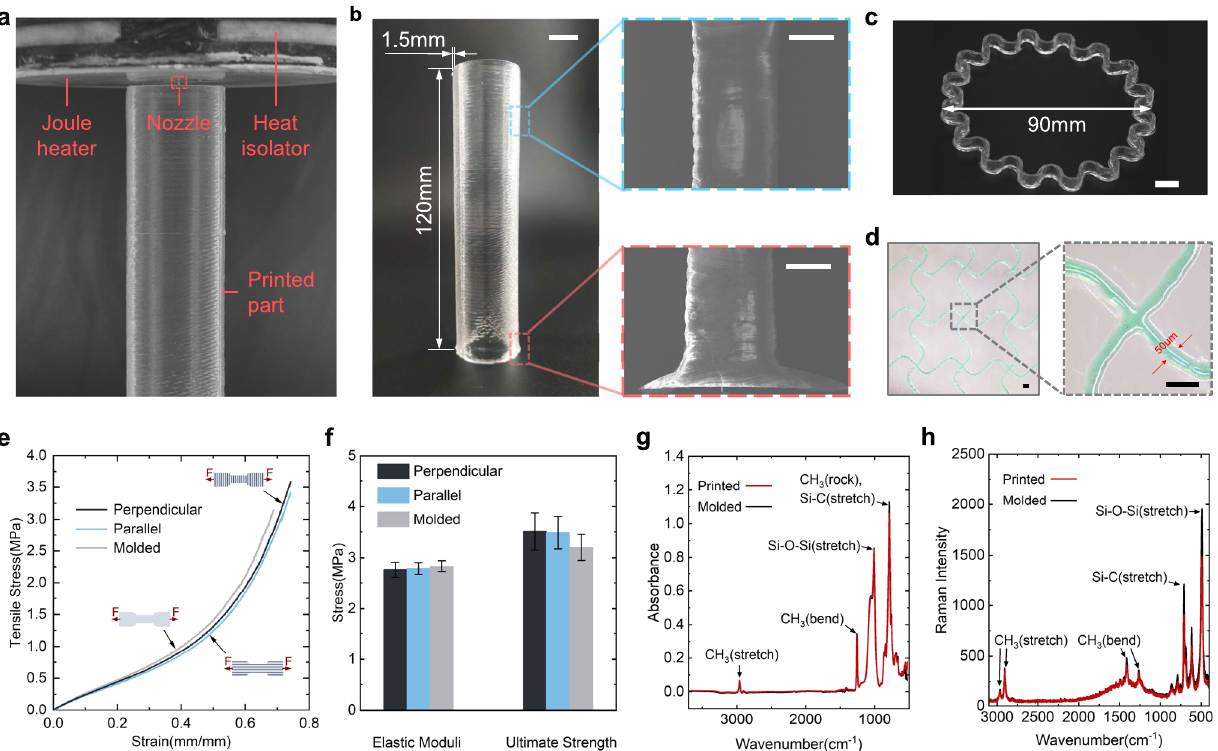
Fig.3|CharacterizationofISDH-enabledDIWoflow-viscositySylgard184with base-to-curing agent ratio of 10:1. a Photograph of printing a cylinder tube. b Optical and scanning electron microscope (SEM) images of a printed cylinder tubewithaheightof120mmandthicknessof1.5mm.(Leftscalebar=12mm,right scale bar=0.8mm). c Optical image of a printed wrinkled ring with a diameter of